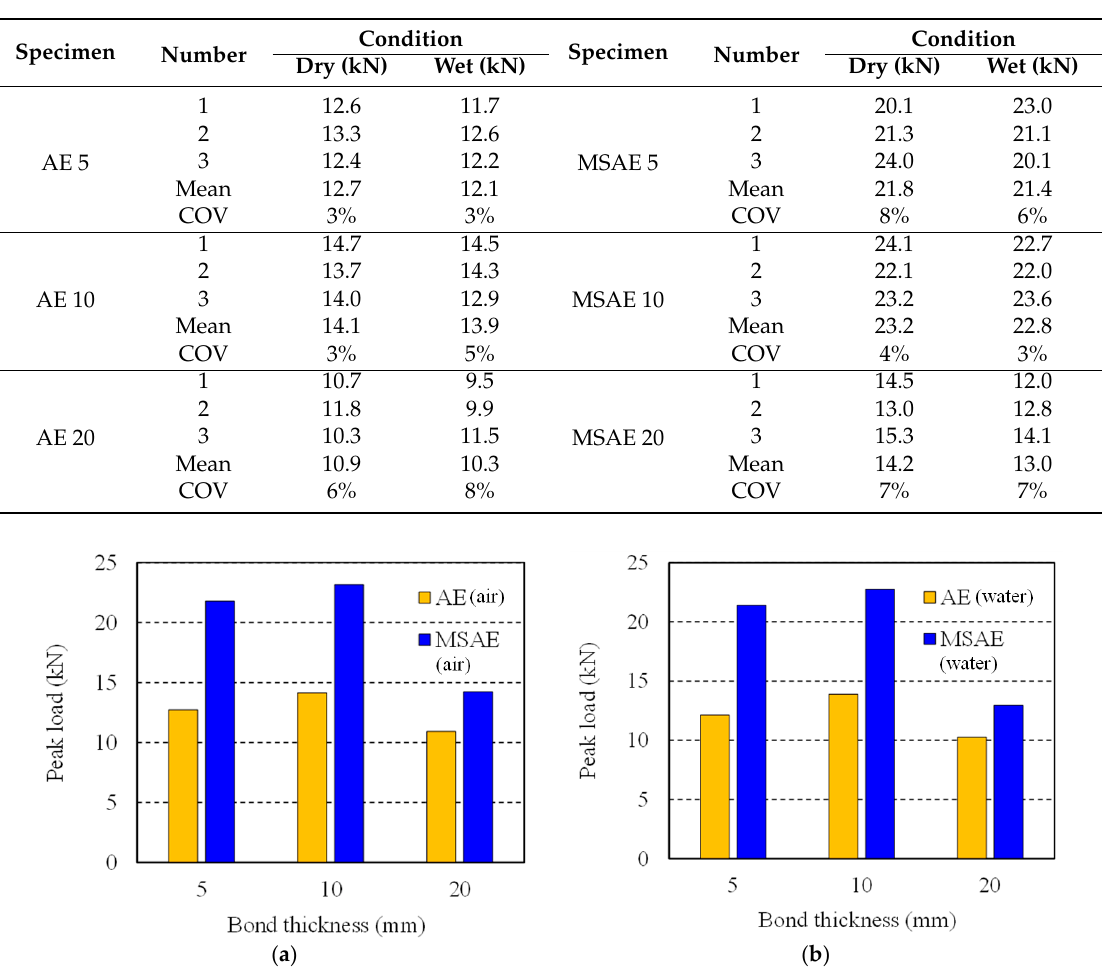
Table 10. Peak loads of three-point bending test.